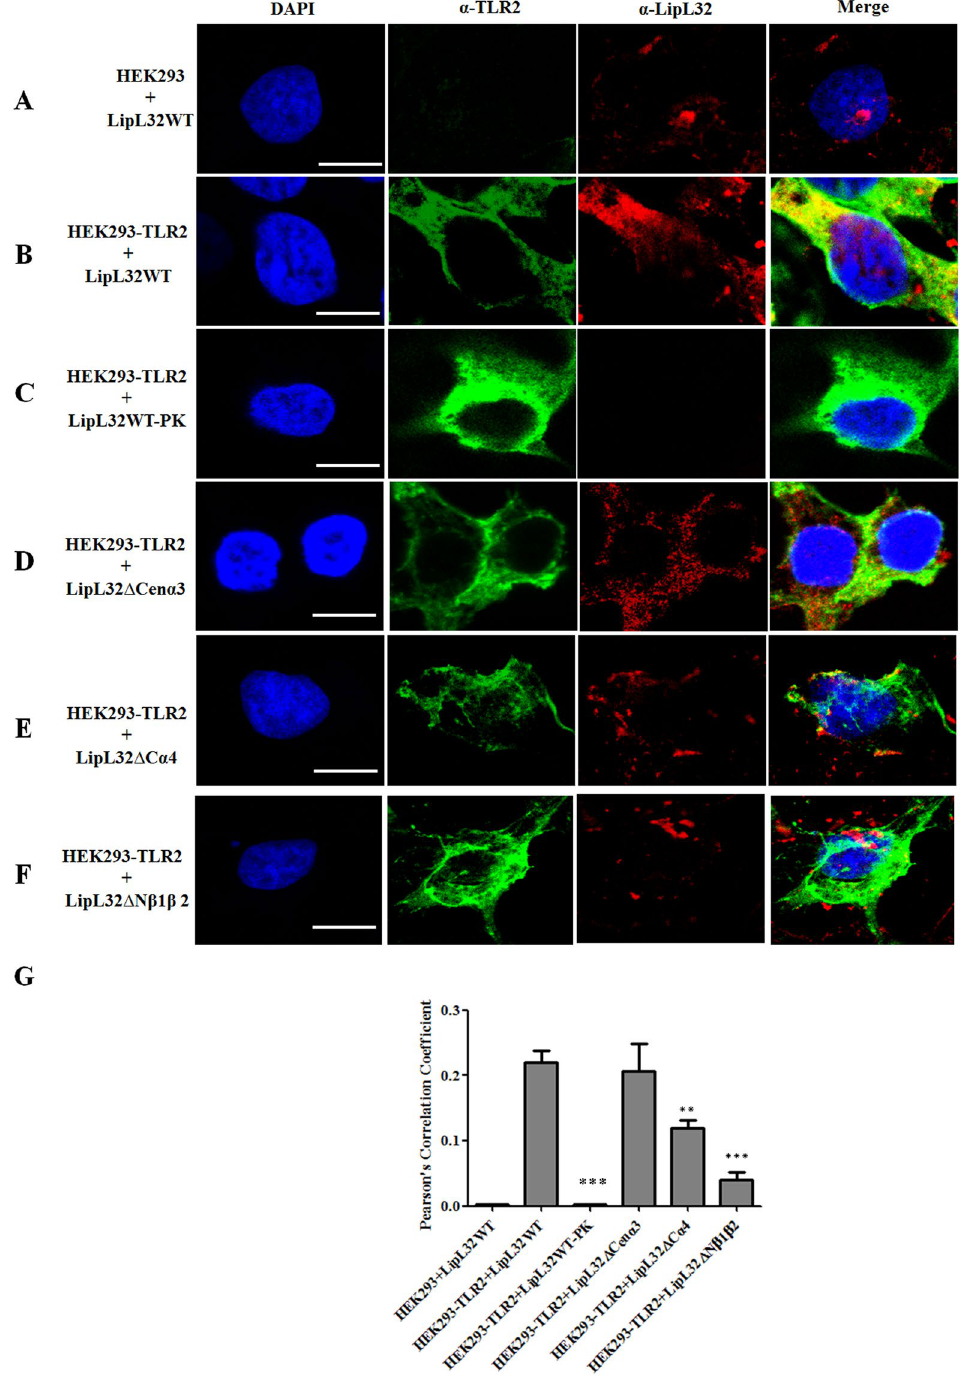
Figure 2. Co-localization of LipL32 and TLR2. The confocal microscopy was used to observe the co- localization of LipL32 and TLR2 on HEK293-TLR2 cell. The purified LipL32 variants were incubated with HEK293-TLR2 cell as described in Materials and Methods and observed by confocal microscopy. TLR2 was stained by Alexa488 (green) and LipL32 was stained by Alexa594 (red). The yellow color indicated that the two proteins were co-localized on HEK293-TLR2 cell. ( A ) HEK293 cell incubated with LipL32WT. ( B ) HEK293-TLR2 cell incubated with LipL32WT. ( C ) HEK293-TLR2 cell incubated with LipL32WT treated with proteinase K (PK). ( D ) HEK293-TLR2 cell incubated with LipL32 Δ Cen α 3. ( E ) HEK293-TLR2 cell incubated with LipL32 Δ C α 4. ( F ) HEK293-TLR2 cell incubated with LipL32 Δ N β 1 β 2. ( G ) Statistic analysis of the co- localization of the LipL32 and TLR2 on HEK293-TLR2 cell. Pearson’s correlation was used to calculate the overlap between image pairs. All conditions are repeated at least three independent experiments. Scale bar, 7.5 μ m; ** p < 0.01; *** p <